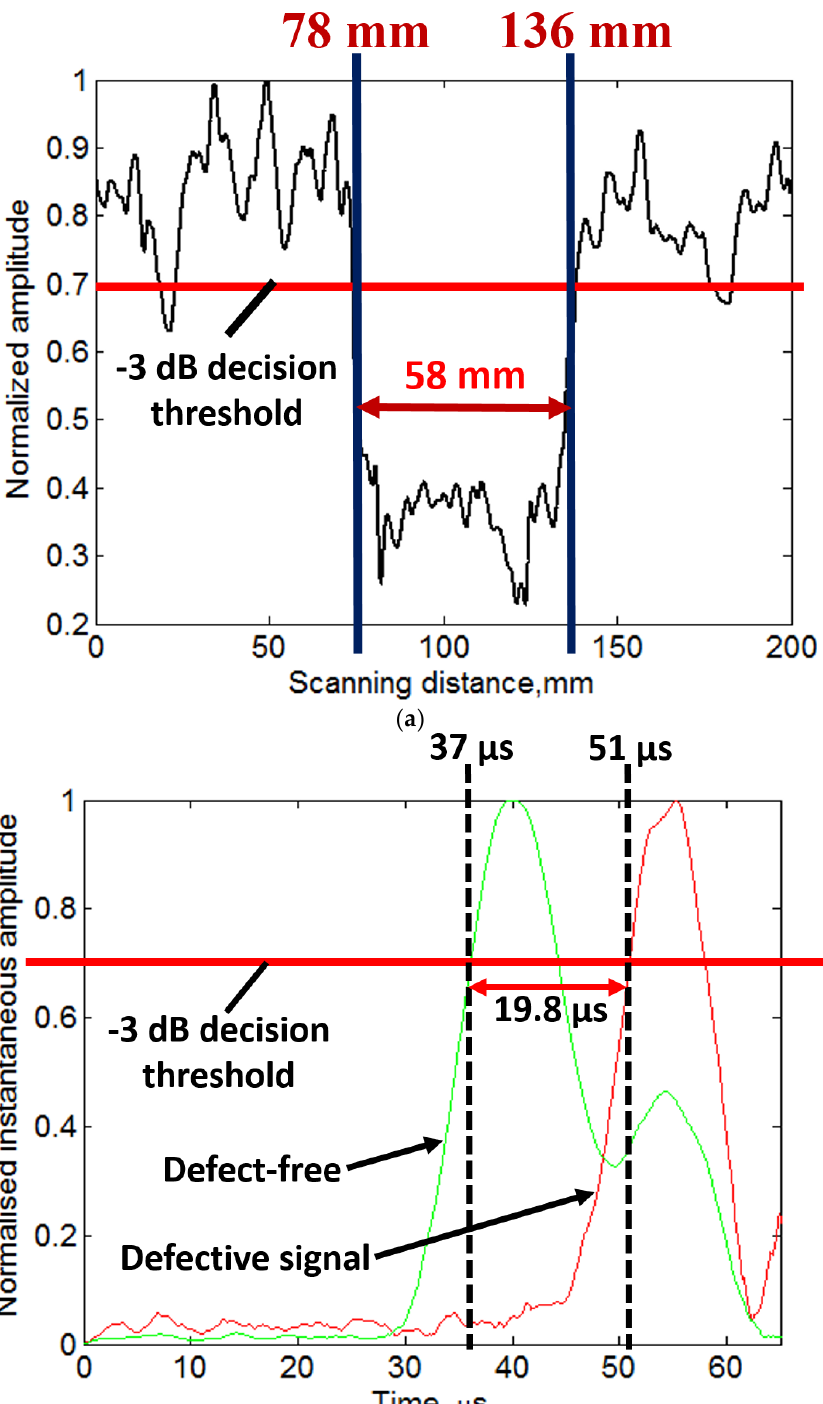
Figure 10. Signal processing to investigate 51 mm defect: ( a ) amplitude detection after wavelet denoising; and ( b ) comparison of instantaneous amplitudes of defect-free and 51 mm defective signal.